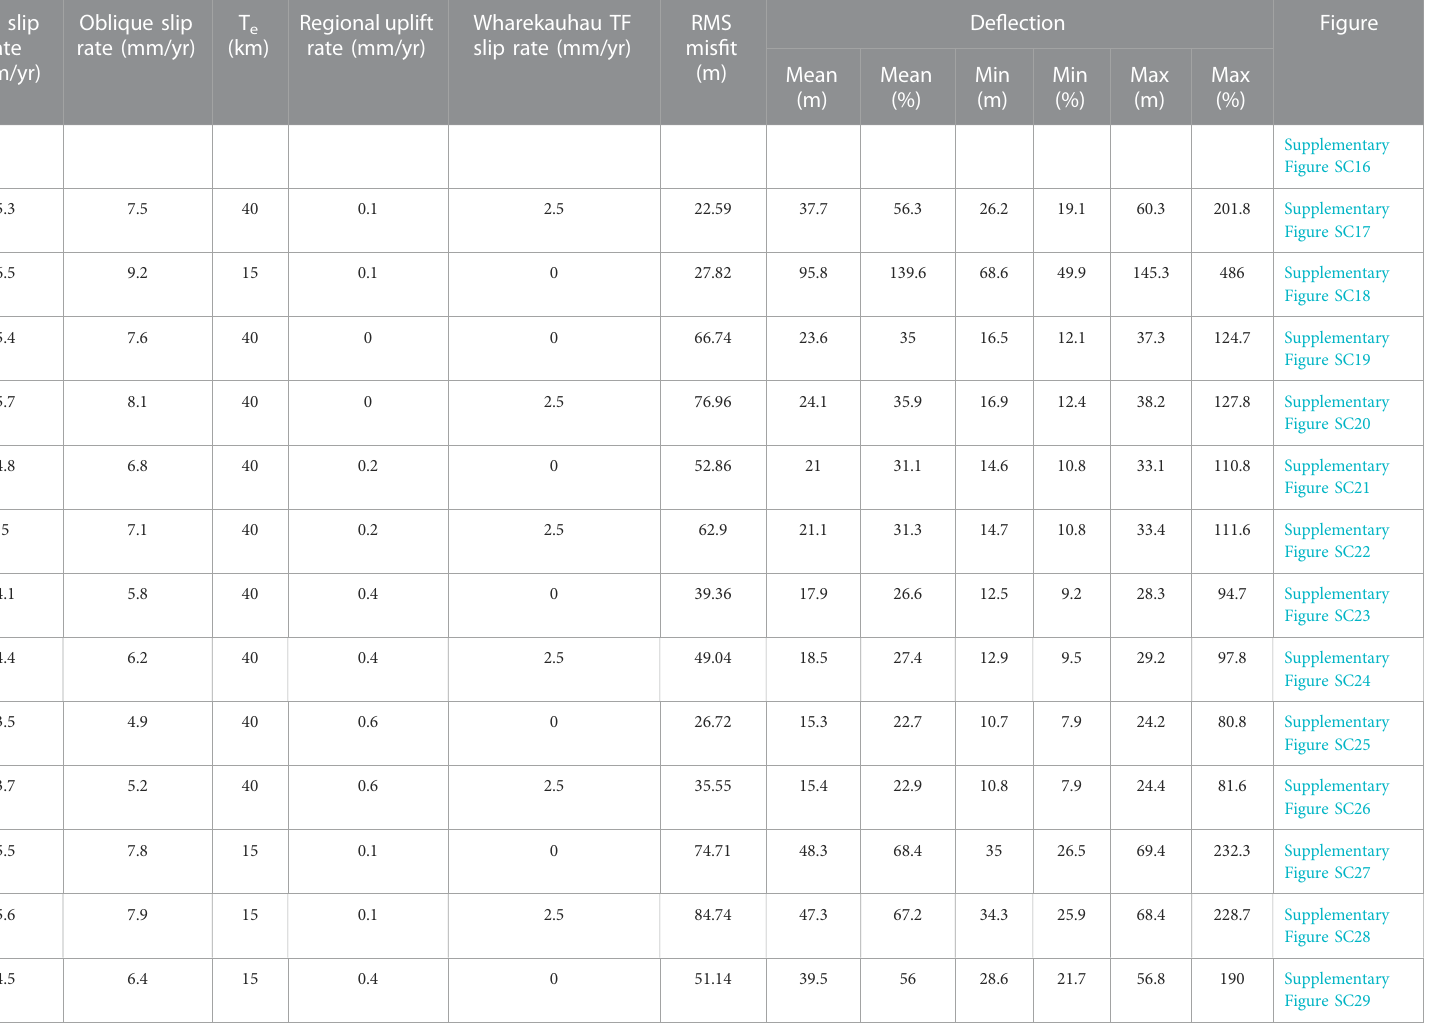
FaultmodelgeometriesarefoundinTable3.Dipsliprateistheslipratethat fi tstheobservedupliftbest,withthelistedRMS(rootmeansquare)mis fi t.Obliquesliprateisthefullfaultslipratecalculatedfromthedipslipratebyassumingarakeof45 ° .T e istheelastic thicknessassumed for thedowngoing Paci fi c Plate for each model scenario. Regional uplift rate is a uniform rate applied to all modelled points to simulate long-wavelength contributions to uplift from processes other than Palliser-Kaiwhata Fault slip. Wharekauhau FaultslipratereferstosliprateofamodelledWharekauhauThrusttoinvestigateitseffectonmodelresults.De fl ectionsarethemaximum,minimumandmeansubsidencecausedbythe fl exuralisostaticresponsetofaultslipandconsequentcrustalthickeningateachsite where uplift rates have been calculated. These are expressed as absolute de fl ections (in metres) and percentages of the magnitude of total uplift at that